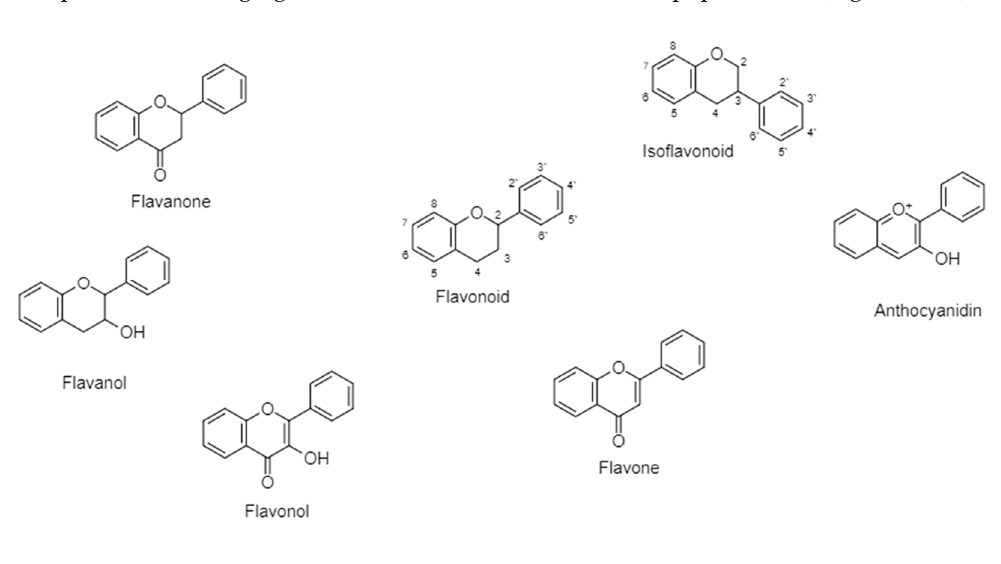
Figure 4. Classification of phytochemicals. alkaloids, carotenoids, n-rich, organo-sulphur compounds, and phenolics, which are further classified as phenolic acids, stilbenes, flavonoids, tannins, and coumarins.